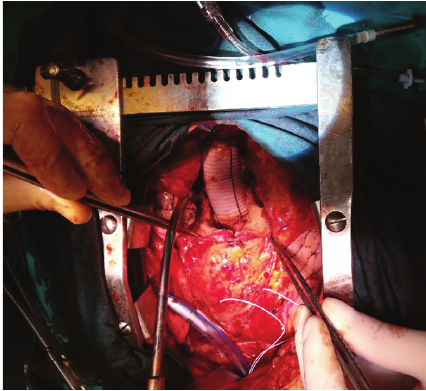
Figure 2: Postoperative view shows completed modified Bentall Procedure.